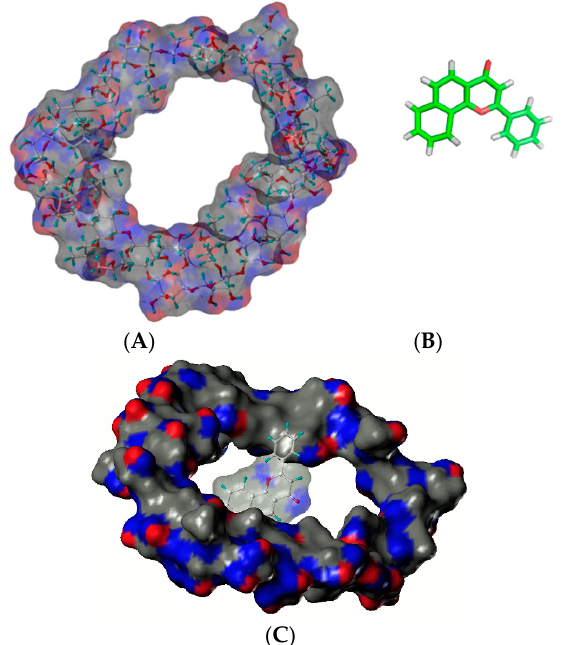
Figure 4. Structures of HP-Cys ( A ) and α -naphthoflavone ( B ). The proposed mode of complex ( C ) [25].